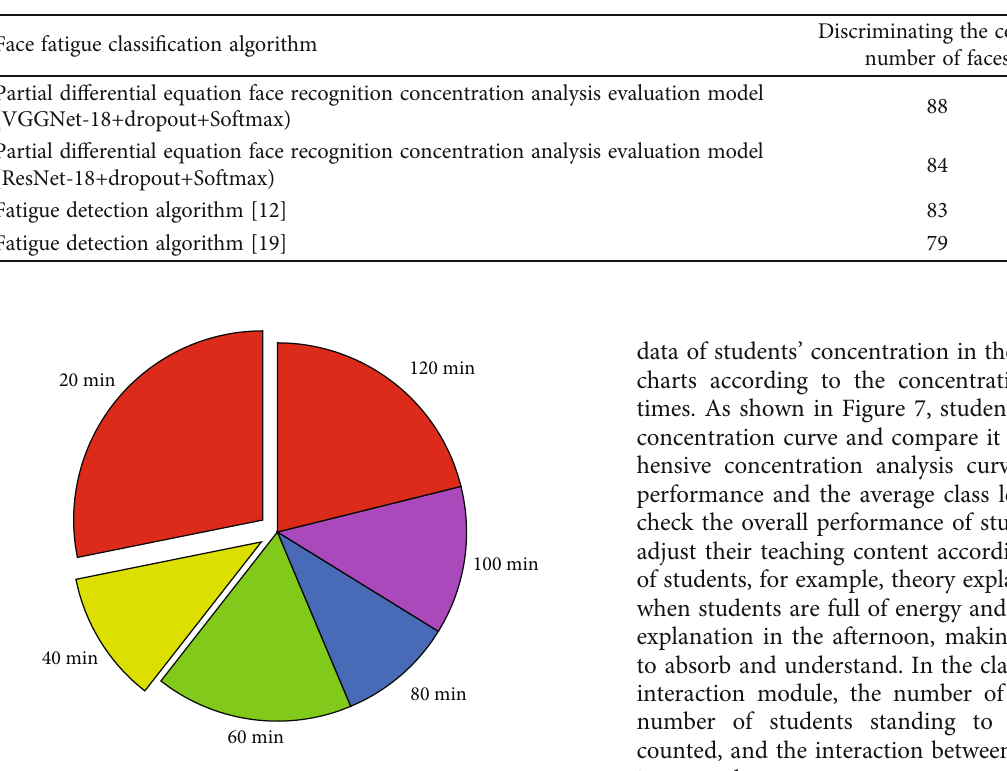
Table 3: Accuracy of concentration analysis and evaluation model of partial di ff erential equation face recognition and other face fatigue detection algorithms on classroom data set (%).